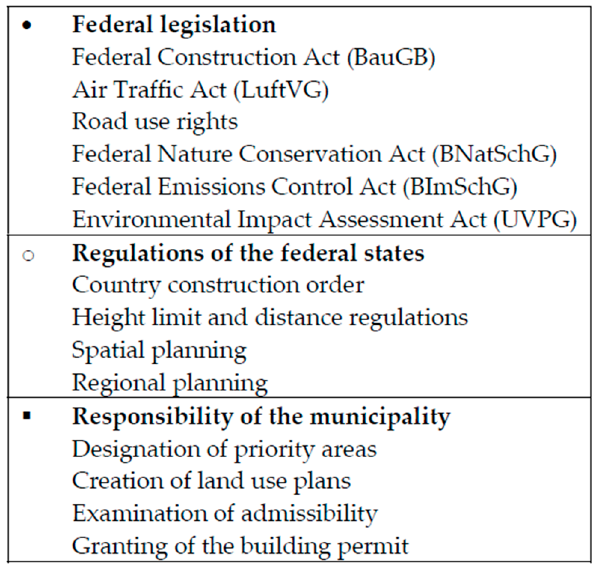
Figure 3. Regulations for the approval of wind turbines [15].